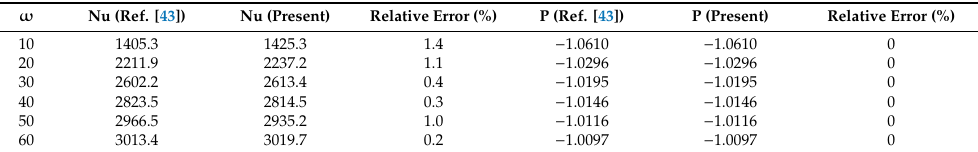
Figure 2. ( a ) Nusselt number and ( b ) dimensionless pressure as functions of pore density compared with previous work [43]. Table 2. Comparison of the predicted Nusselt number (Nu) and dimensionless pressure di ff erence (P) with [43] (u m = 10 m.s − 1 , ε = 0.9, k f /k s = 10 − 4 , H = 0.005 m ) .